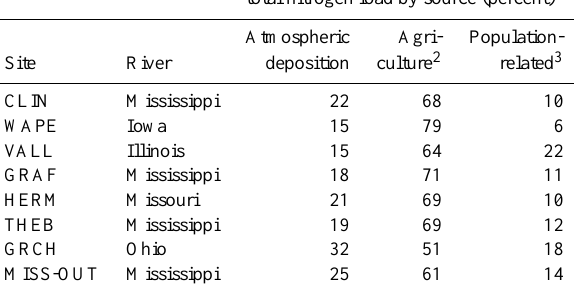
Table 2. Relative contributions of total nitrogen load by source estimated using the SPARROW model (SPAtially Referenced Re- gression On Watershed attributes) decision support system (Missis- sippi/Atchafalaya Basin Total Nitrogen Model – 2002; http://cida. usgs.gov/sparrow/).